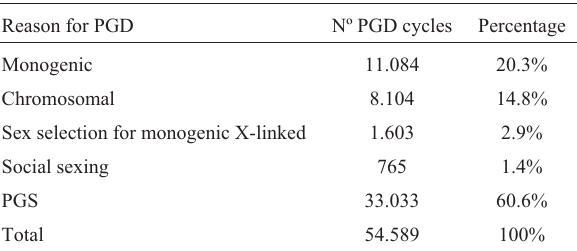
Table3 -DifferentreasonsforPGDfromtheI-XIVESHREPGDConsor- tium data